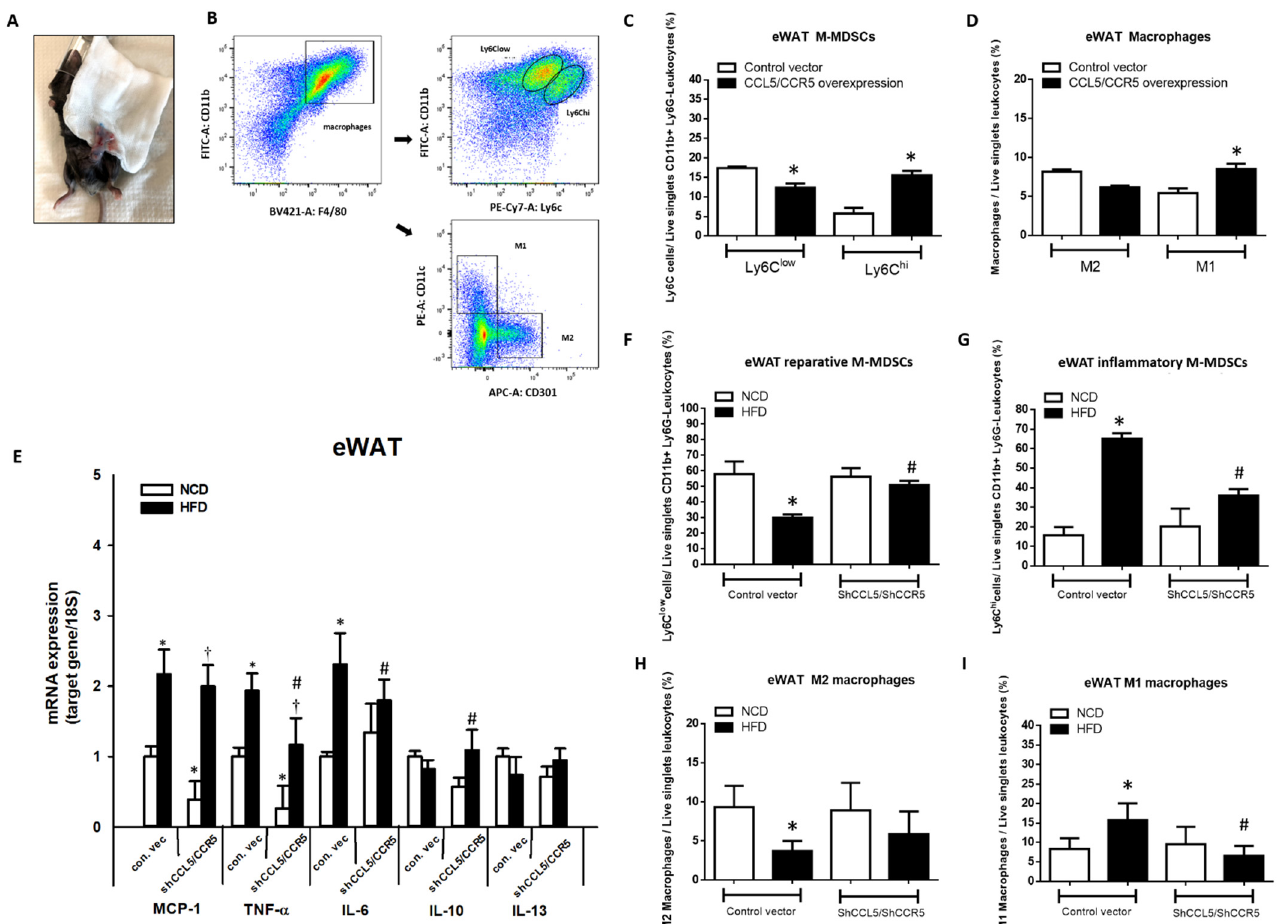
Figure 6. Overexpression and knockdown of local CCL5/CCR5 expression substantially affected the recruitment and trans-differentiation of pro-inflammatory M-MDSCs and M1 macrophages in bilateral eWAT of WT mice. ( A ) Mice were injected with either control and lentivirus-derived CCL5 and CCR5 full-length cDNA or CCL5 and CCR5 shRNA ( n = 5 each group) into bilateral eWAT; the injected tissues were harvested on day 5 post-injection to analyze CCL5/CCR5-mediated local effects via flow cytometry; ( B ) flow cytometric analysis of ( C ) the M-MDSC population and ( D ) M1 and M2 macrophages in the SVCs of eWAT injected with lentivirus-derived CCL5 and CCR5 full-length cDNA; ( E ) total mRNA was extracted from eWAT injected with CCL5 and CCR5 shRNA and used for qPCR analysis of the gene expression of M1 macrophage markers and M2 macrophage markers; ( F ) the CD11b + Ly6G − Ly6C low subset represents reparative M-MDSCs; ( G ) the CD11b + Ly6G - Ly6C hi population represents pro-inflammatory M-MDSCs; ( H ) M2 macrophages; ( I ) M1 macrophages in the SVCs of treated eWAT. All data are presented as mean values ± SEM from at least 5 mice in each group. Statistical differences are indicated: *, p < 0.05 vs. control-vector NCD; #, p < 0.05 vs. control-vector HFD; †, p < 0.05 vs. shCCL5/shCCR5-NCD.